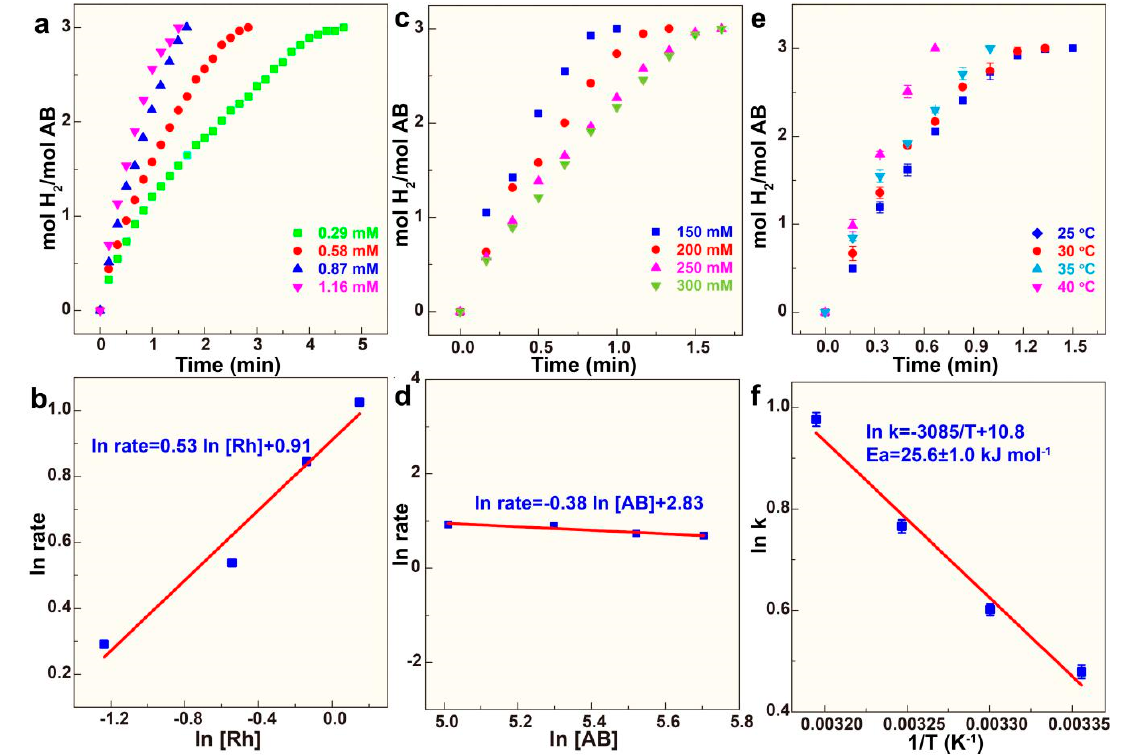
Figure 3. Plot of hydrogen production vs. time over Rh / nano-DA with varied ( a ) Rh and ( c ) ammonia–borane (AB) concentrations, as well as ( e ) temperatures. Logarithmic plots of hydrogen generation rate (HGR) vs. ( b ) Rh and ( d ) AB concentration. ( f ) Corresponding Arrhenius plot.